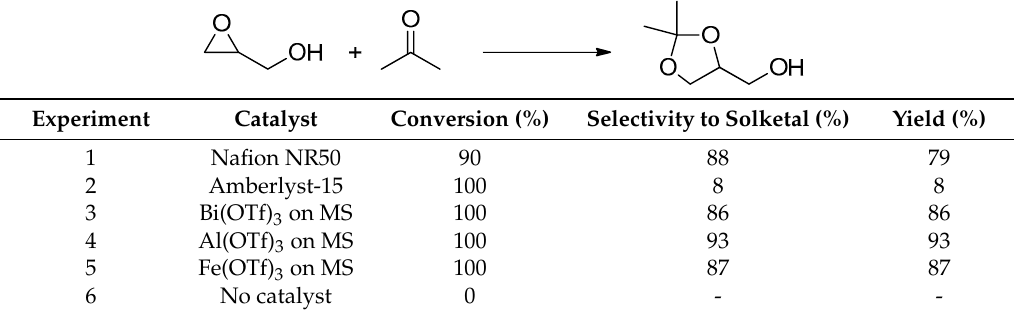
Table 1. Glycidol conversion to solketal in the presence of heterogeneous catalysts.